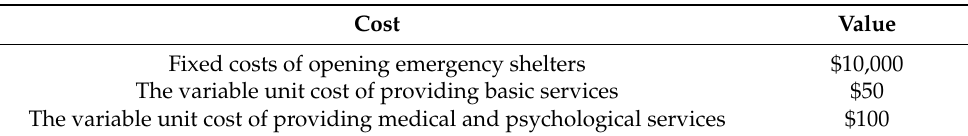
Table 4. Cost parameters used in the case study.